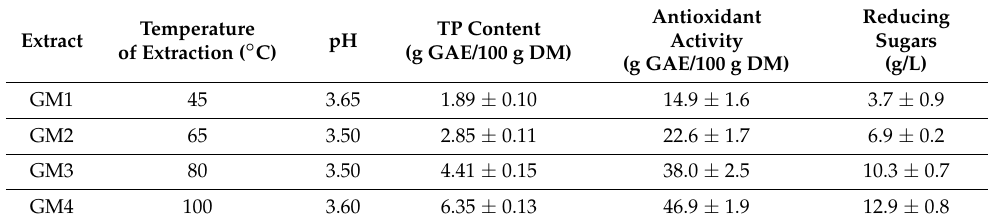
Table 1. Chemical composition and pH of grape marc extracts prepared at different extraction temperatures.